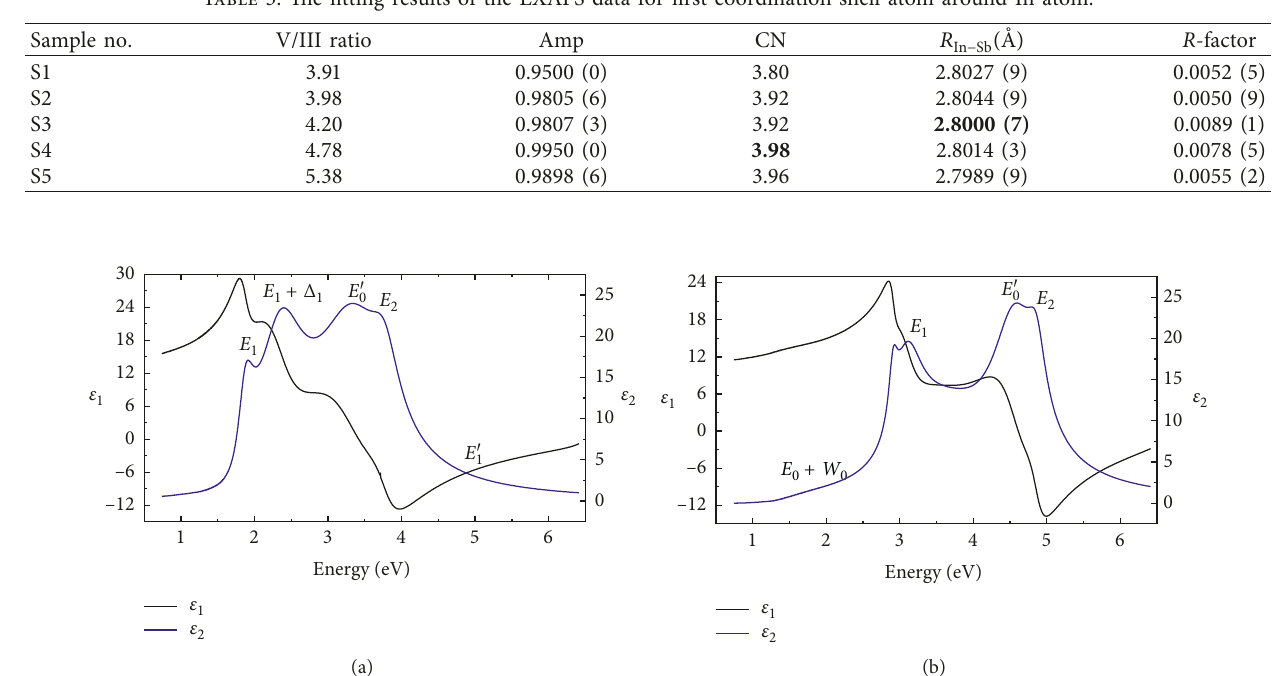
Figure 6: The dielectric functions of the bulk InSb and bulk GaAs.